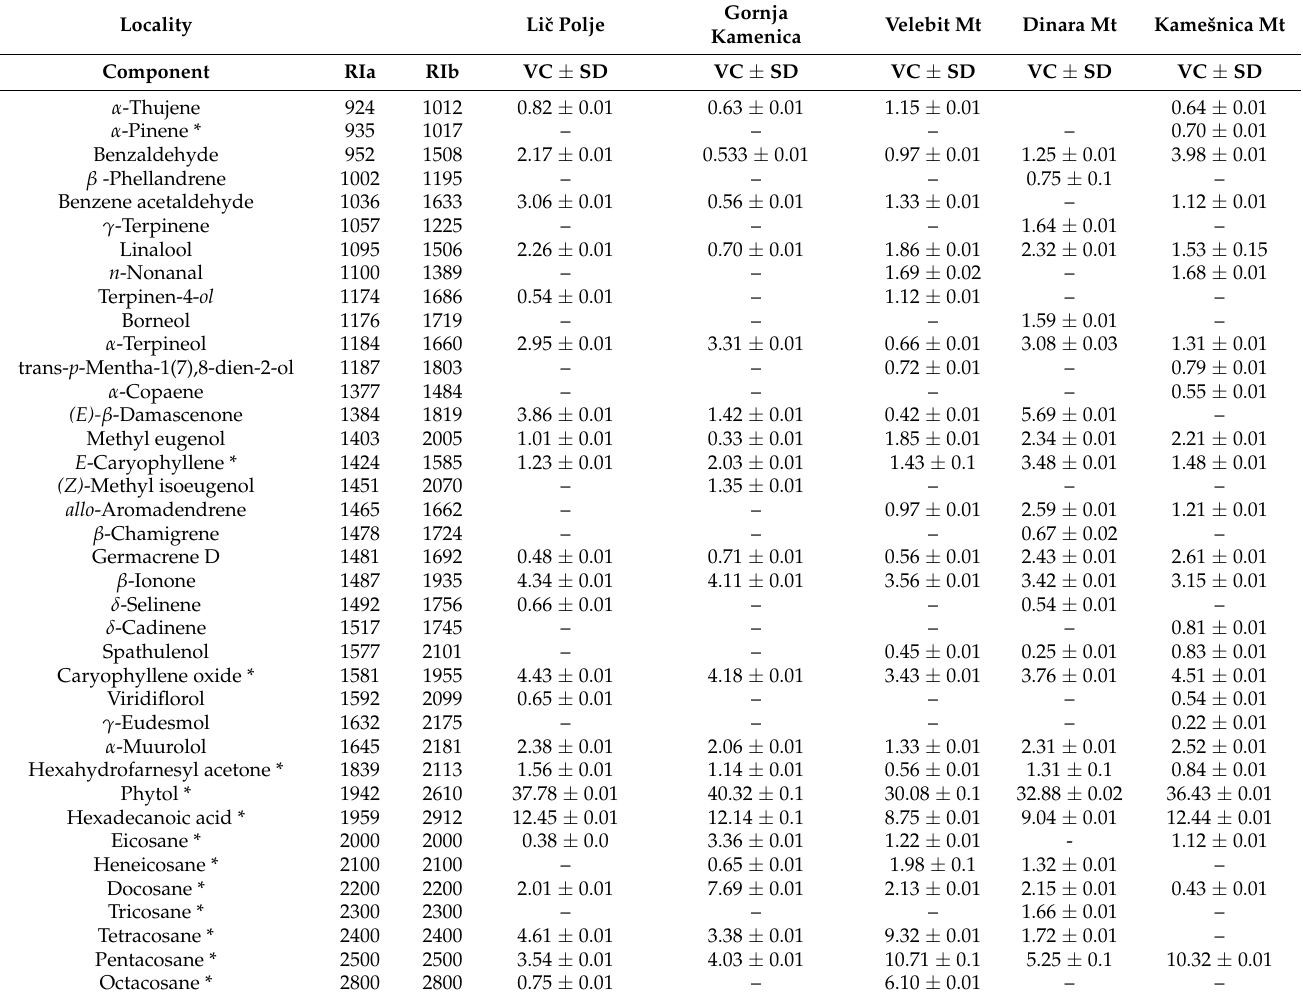
Table 2. Chemical composition of the volatiles of Barrelier’s Speedwell from five different